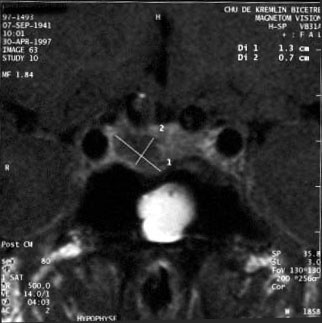
Pituitary microadenoma.